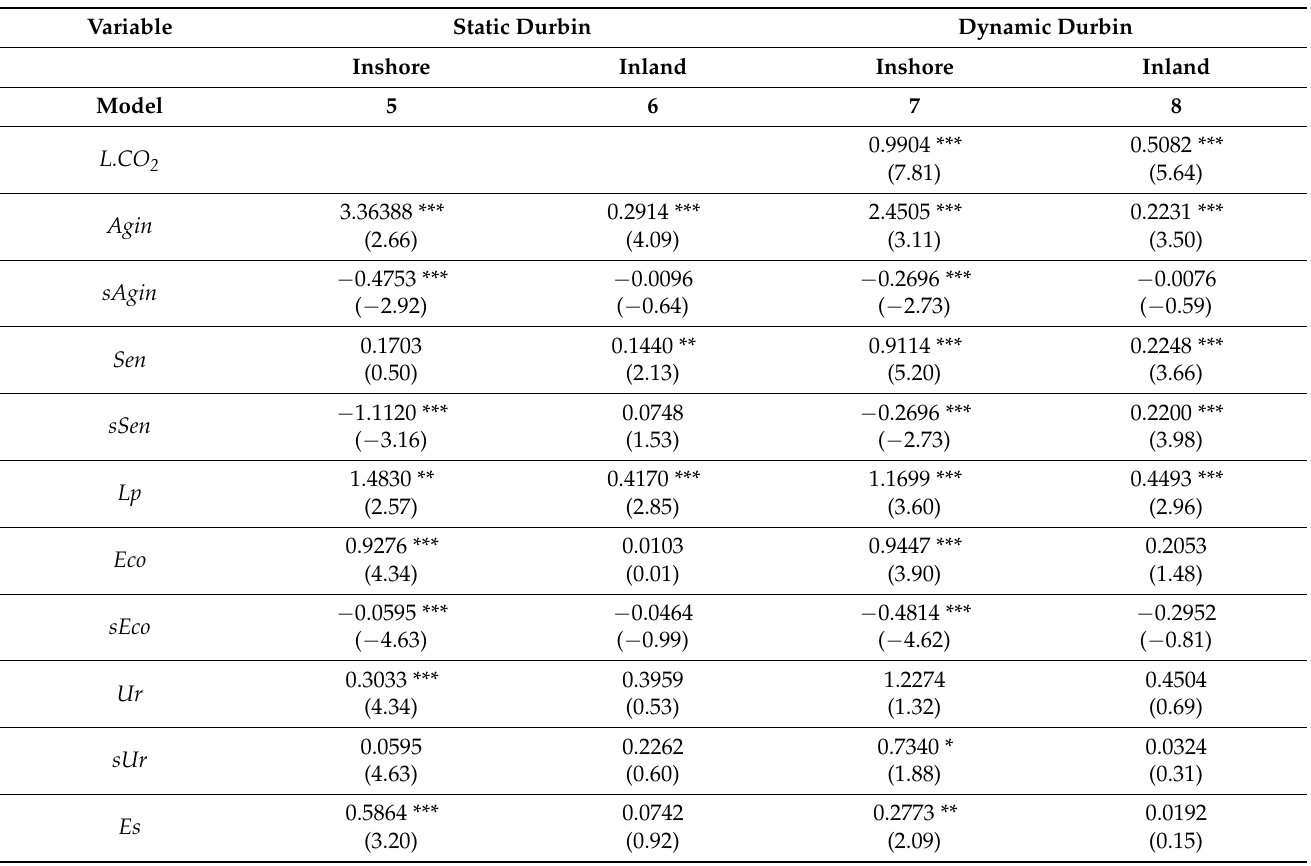
Table 5. Regional test based on the spatial Durbin